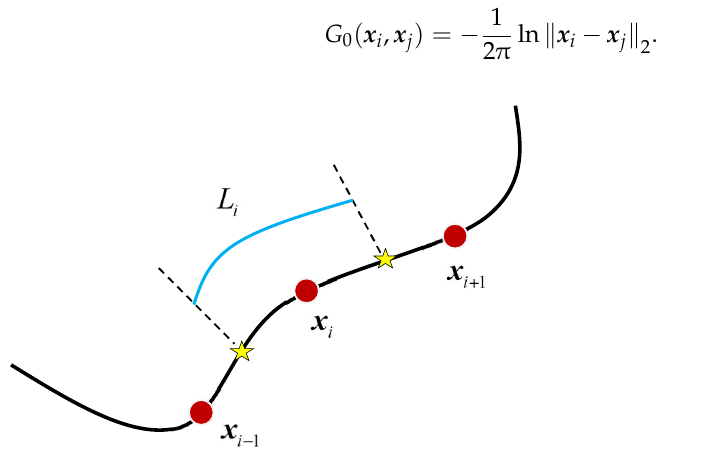
Figure 2. Diagram of the influence range for a source point.